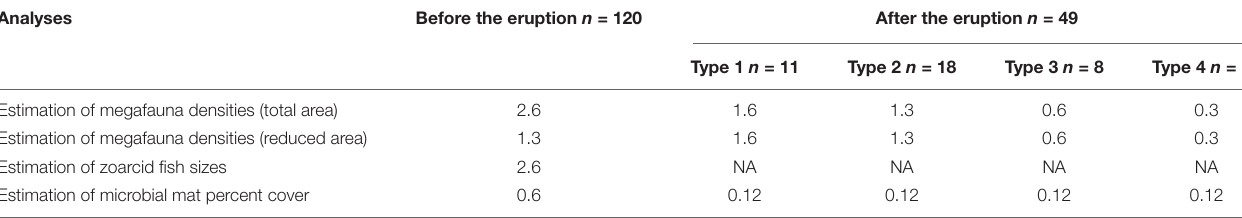
TABLE 1 | Total surface area (m 2 ) considered in megafauna and microbial mat cover analyses before and after the eruption. Analyses Before the eruption n = 120